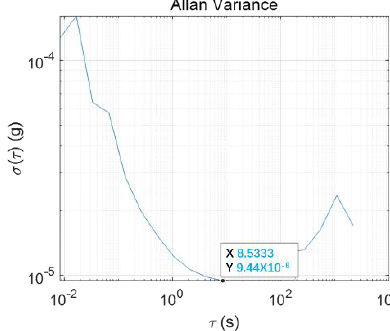
Figure 11. The Allan deviation.